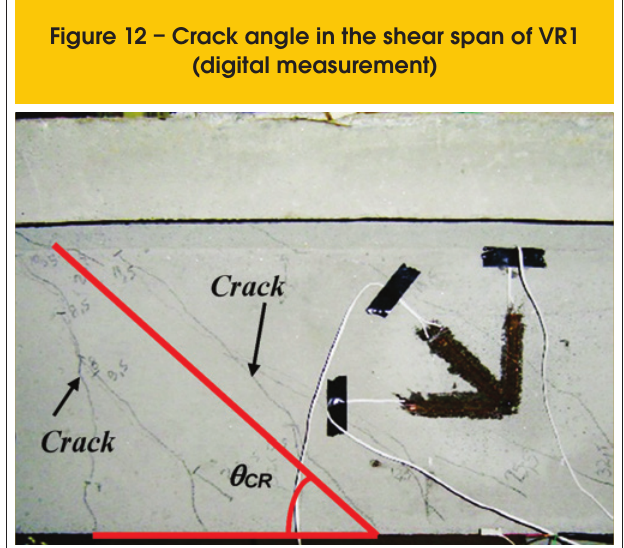
Figure 12 – Crack angle in the shear span of VR1 (digital measurement)